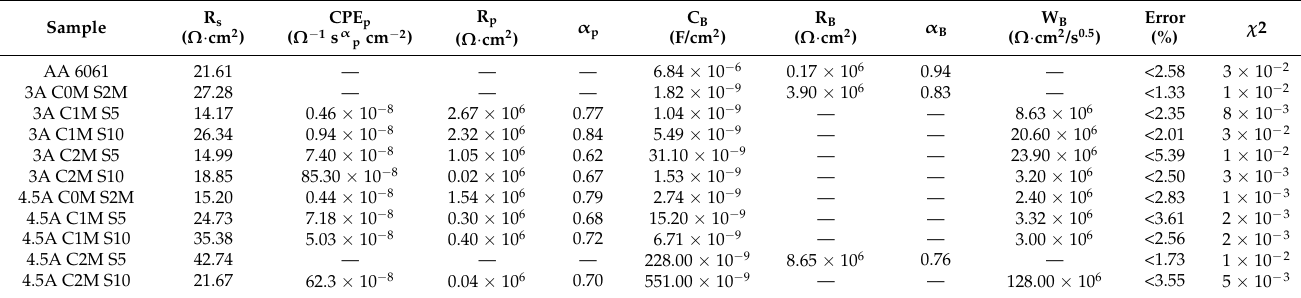
Table 4. EIS Data Obtained by Equivalent Electric Circuit Simulation of the AA 6061 Samples at Different Conditions. Sample R s ( Ω · cm 2